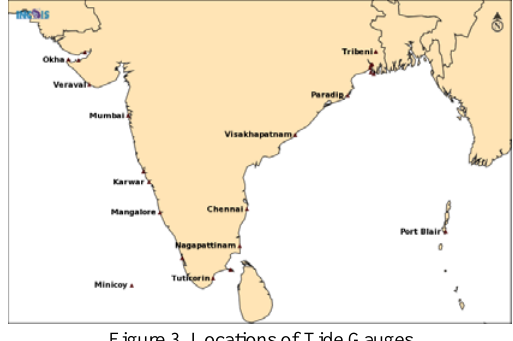
Figure 3. Locations of Tide